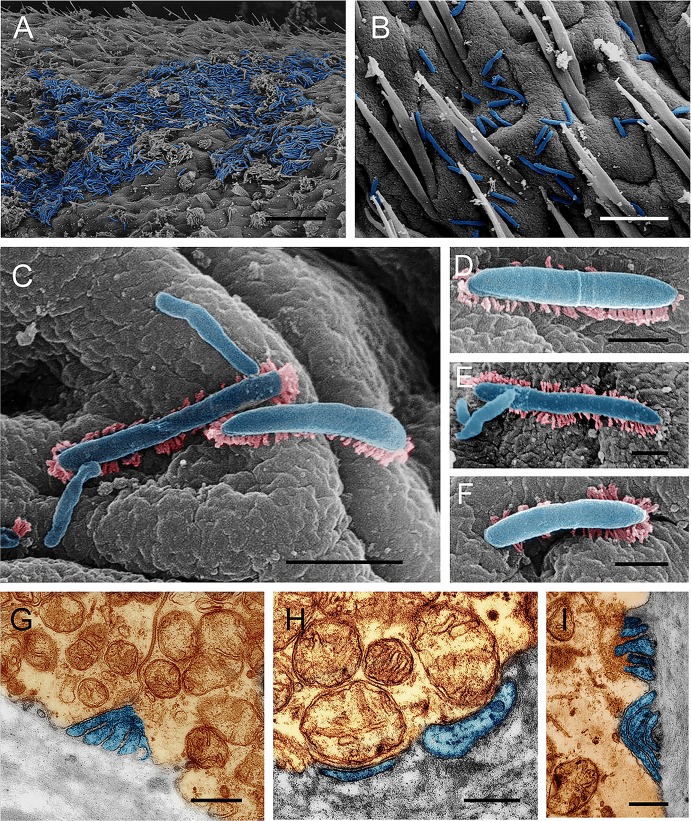
The bacterial morphology and association with the epithelium surfaces in the hindgut of CMC.Scanning electron microscopy (A-F) and transmission electron microscopy (G-I), show that rod-shaped bacteria sticking to the cell surface directly or by pili-like structures (C-F), bacteria invaginating the epithelium (G, I). Brown represents the epithelium, light blue indicates the bacteria, and pink represents the pili-like structure. Scale bar = 15.0 μm (A), 5.0 μm (B, G, I) and 1.0 μm (C), and 0.4 μm (D, E, F, H).